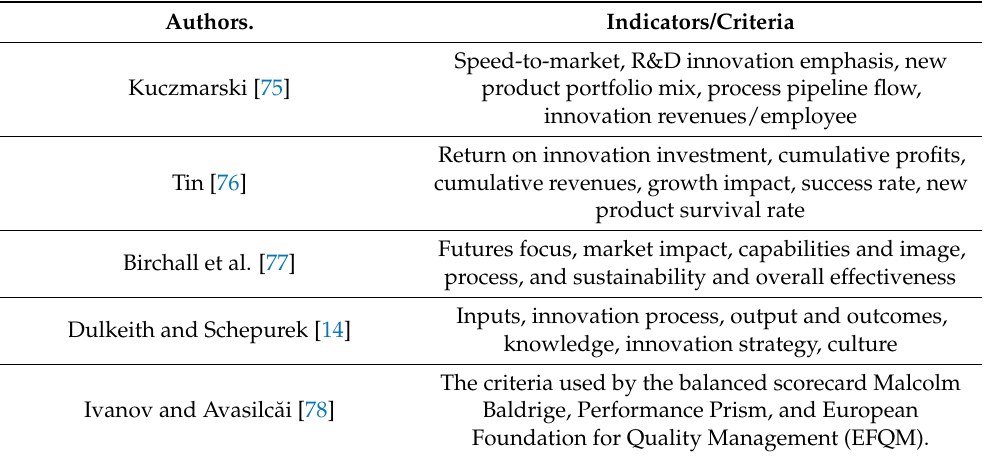
Table 1. Indicators/criteria for innovation